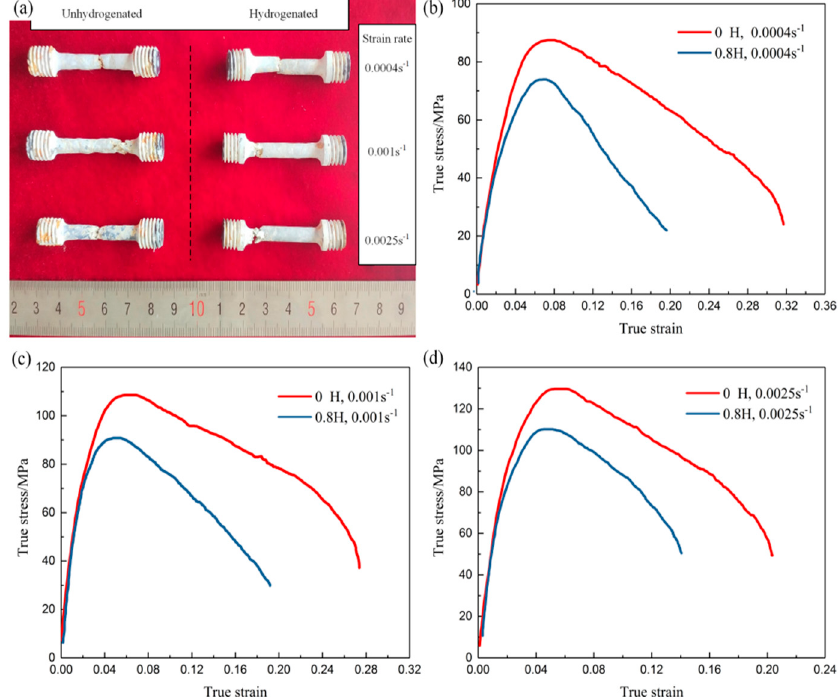
Figure 5. Tensile deformed specimens ( a ) and true stress-true strain curves ( b – d ) of the unhydrogenated and hydrogenated Ti–45Al–9Nb alloys deformed at ( b ) 1150 ◦ C / 0.0004 s − 1 , ( c ) 1150 ◦ C / 0.001 s − 1 , and ( d ) 1150 ◦ C / 0.0025 s − 1 .